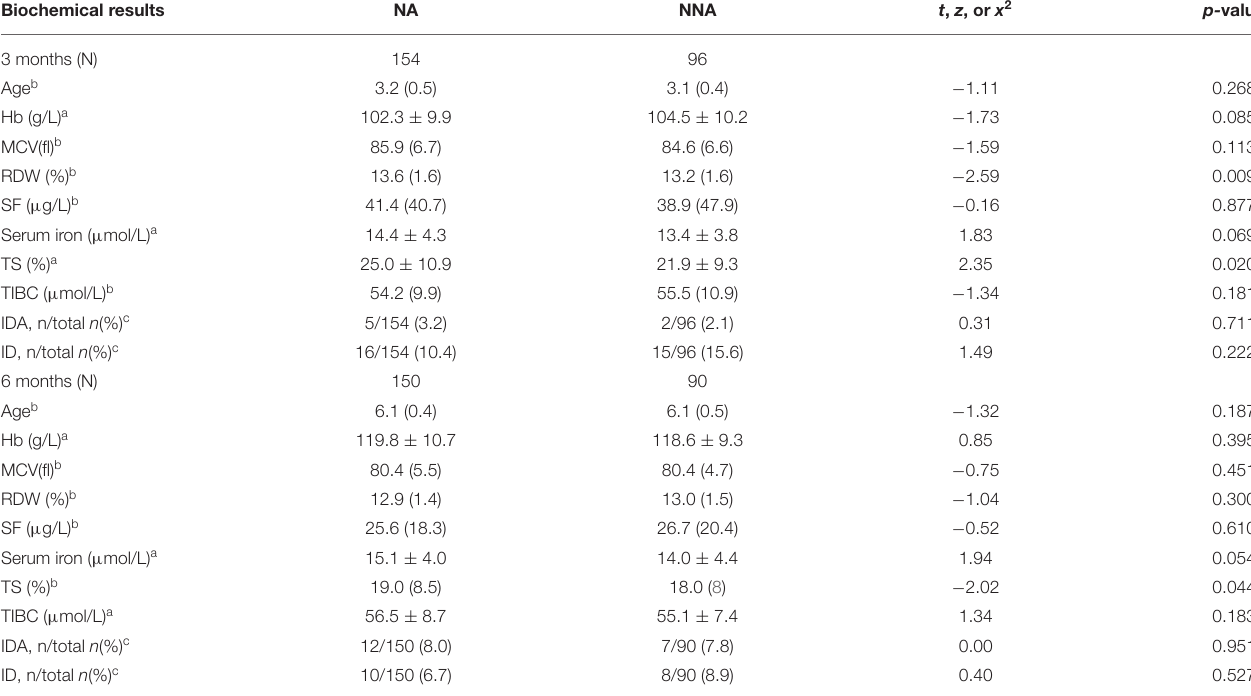
TABLE 2 | Infant iron status at 3 and 6 months’ assessments by group. Biochemical